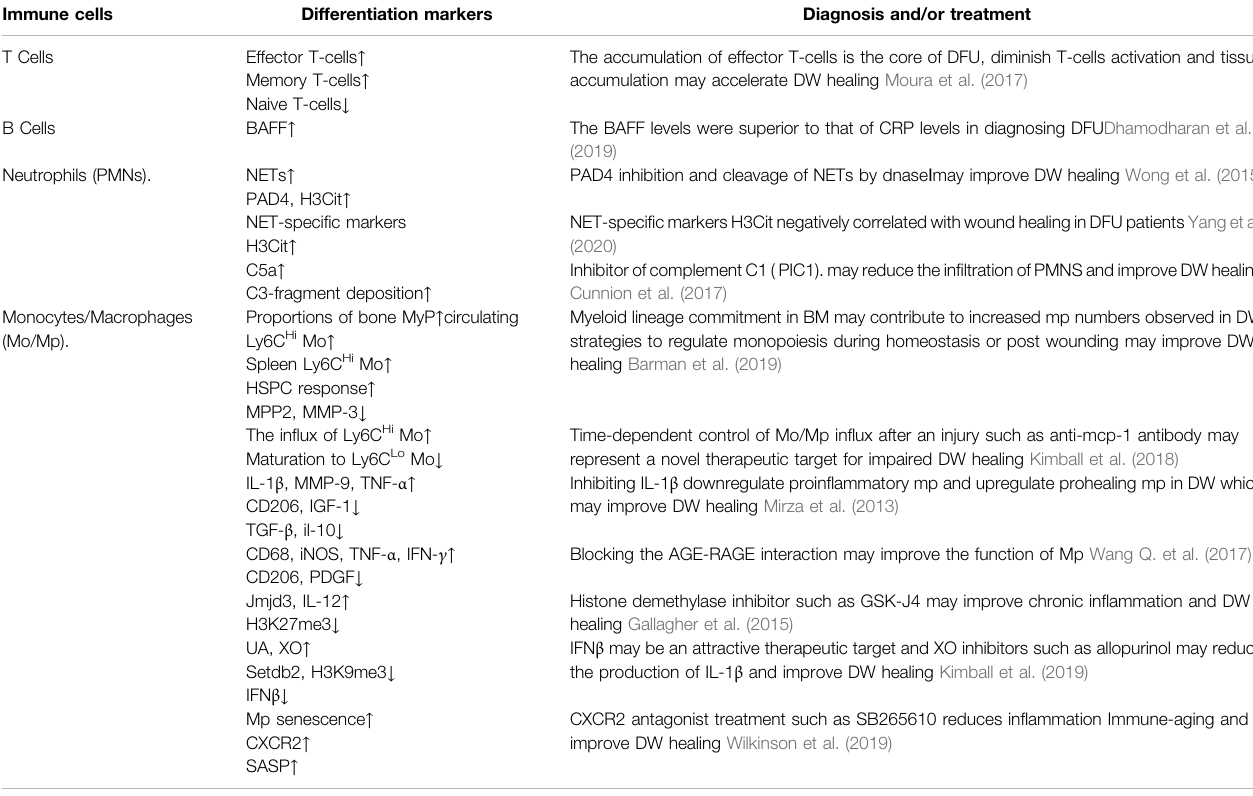
TABLE 1 | Markers of immune cells that can be used for diagnosis and/or treatment in DW. Immune cells Differentiation markers Diagnosis and/or treatment T Cells